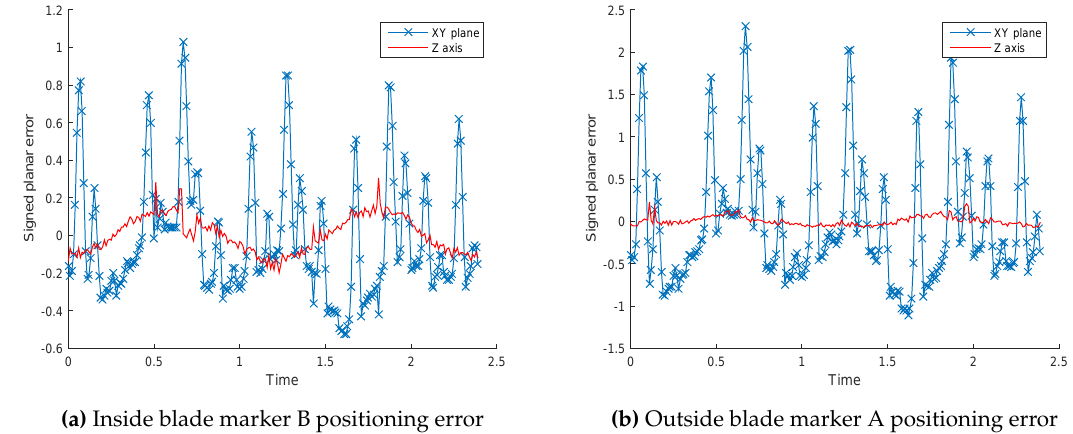
Figure 9. In-plane and Out-of-plane positioning error from Dataset